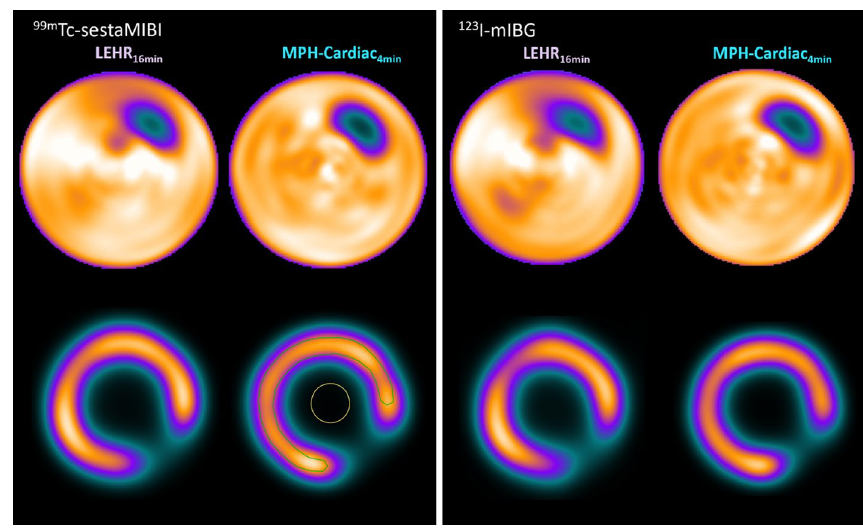
Fig. 4 Polar Map representations of the Data Spectrum LV insert phantom filled with 99m Tc (left upper row) and 123 I (right upper row) measured with the AnyScan SC with LEHR 16 min acquisition and the AnyScan TRIO with MPH‑Cardiac collimator 4 min acquisition. Short axis images of the reconstructed LV inserts are presented for the 99m Tc (left lower row) and 123 I (right lower row) measurements. Half‑moon shaped ROI was applied on both the myocardium region of the phantom (green) and a circular ROI within the LV cavity (yellow). These ROIs were applied on all four LV SPECT images and CNR values were calculated based on Eq. 3